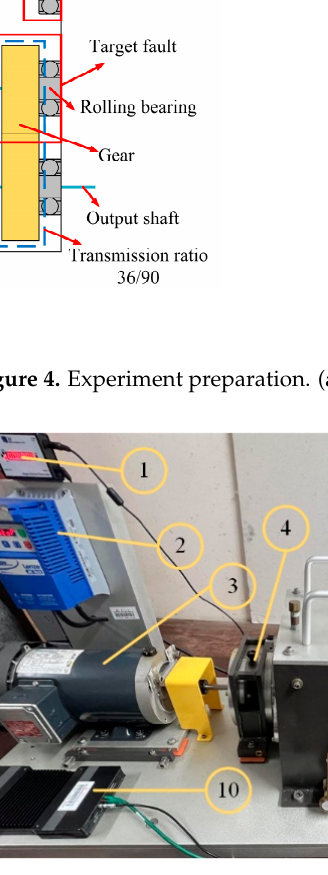
Table 1. Details of the rolling bearing